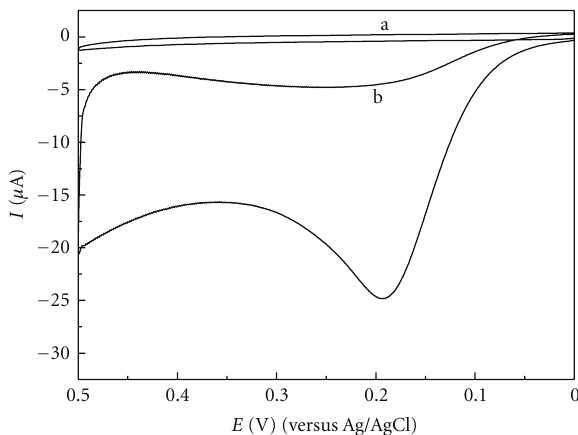
Figure 2: Electrochemical impedance spectra of bare GCE (a) and nano-CuO/GCE (b) in 1mM [Fe(CN) 6 ] 3 − / 4 − + 1M KCl.